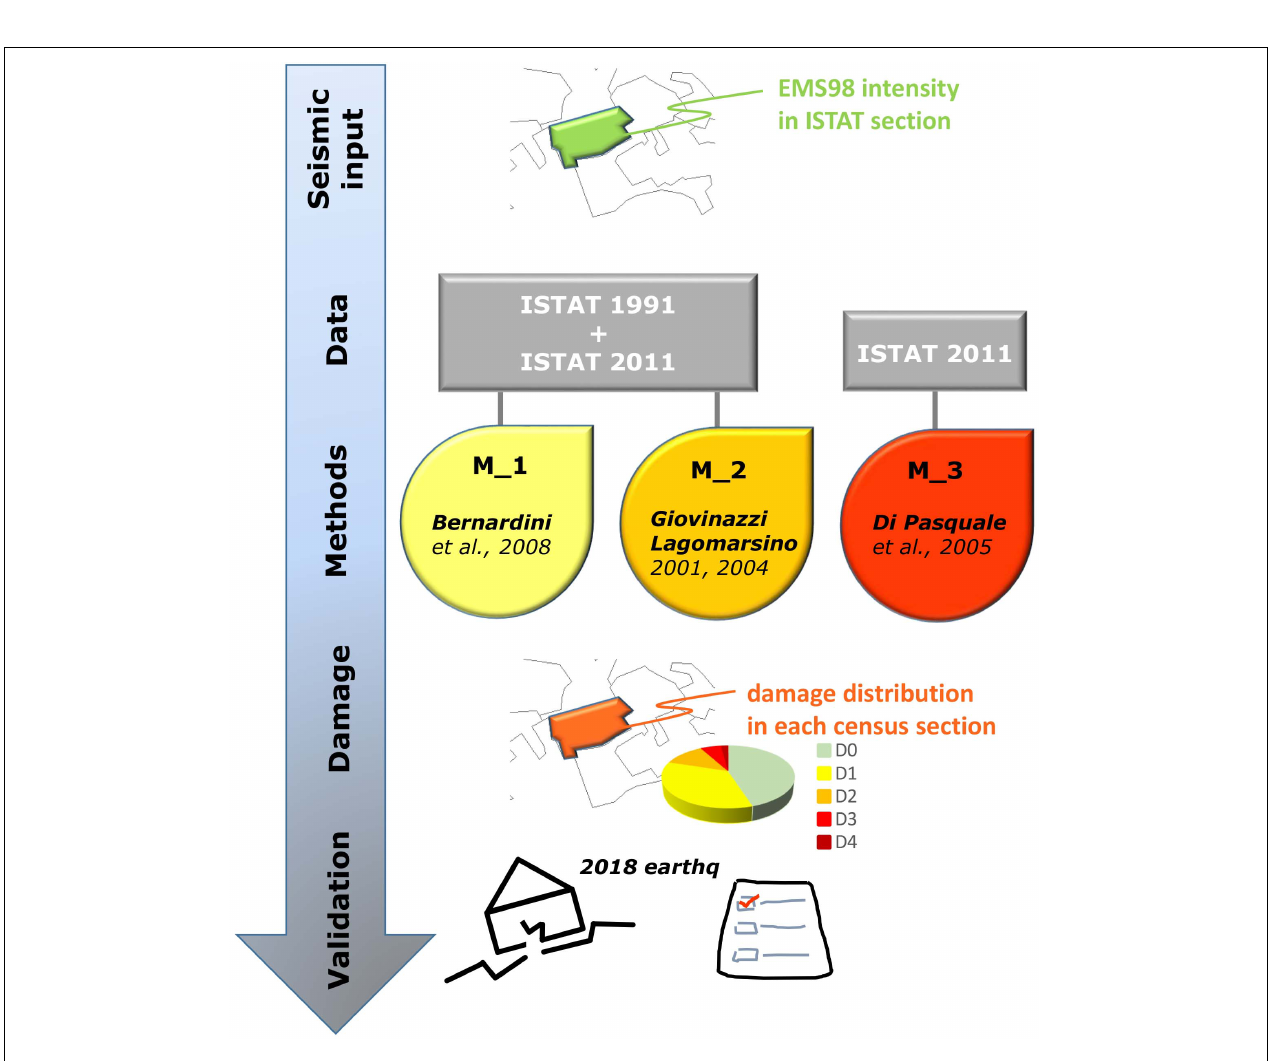
FIGURE 5 | Conceptual scheme of the procedure for damage scenario assessment by using census data on the building stocks.